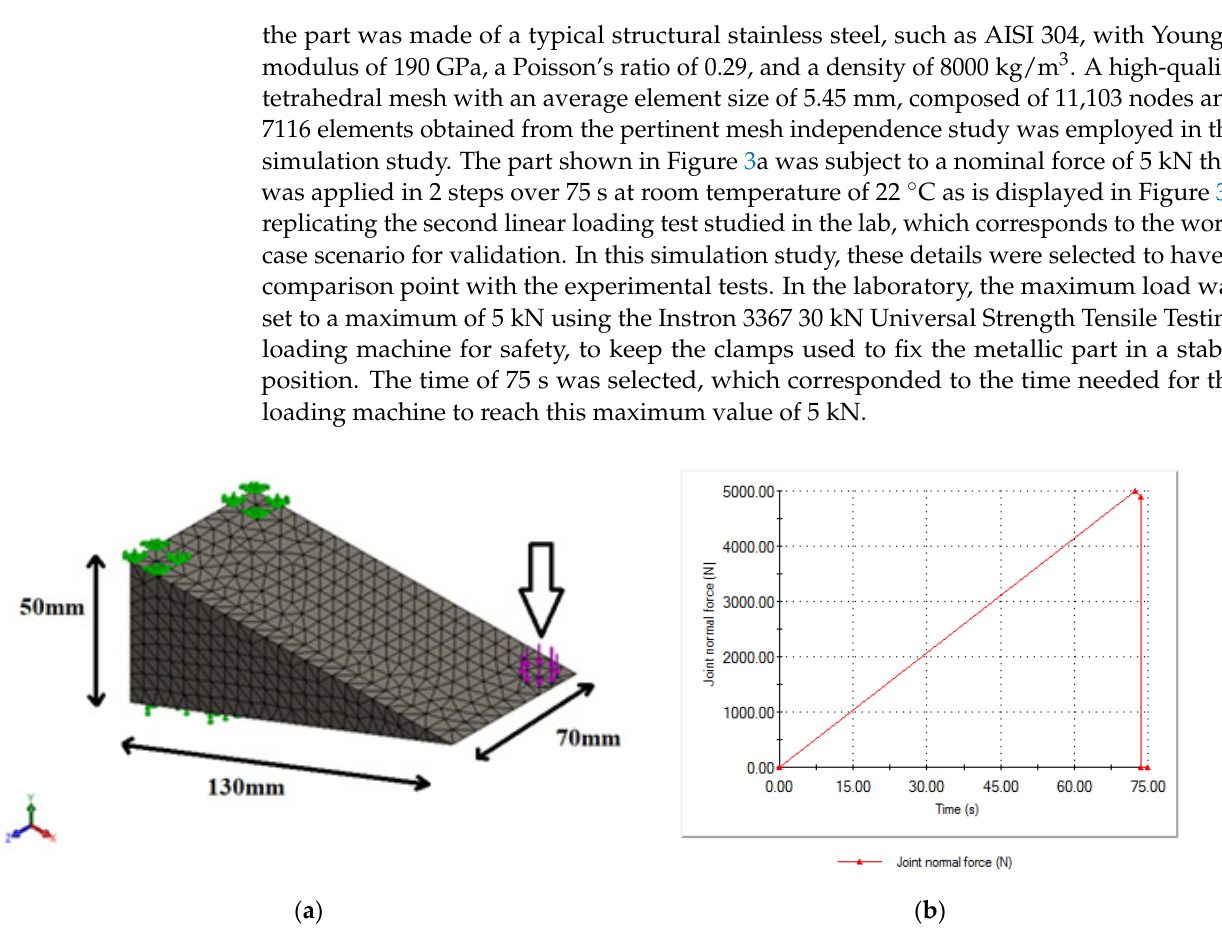
Figure 3. ( a ) Three-dimensional (3D) meshed model and ( b ) applied force used in the simulation model.